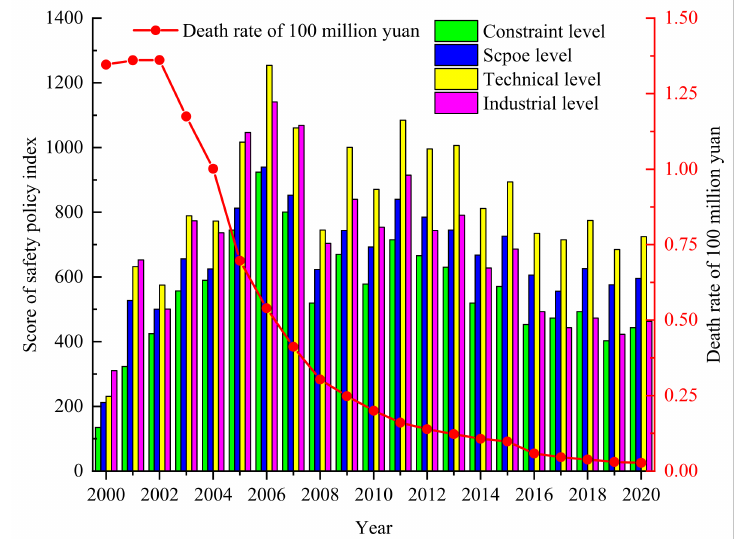
Figure 4. Trend in safety policy indexes.